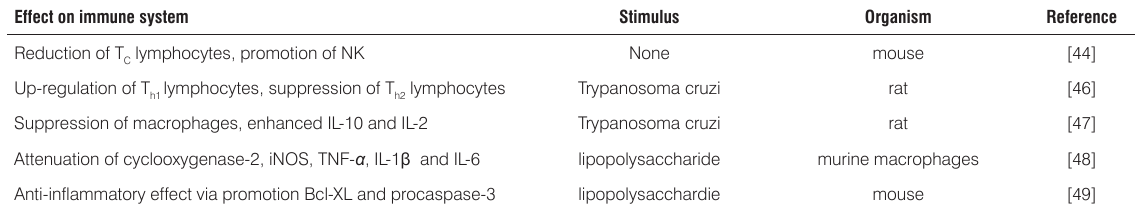
Table 2. Regulation of immunity by